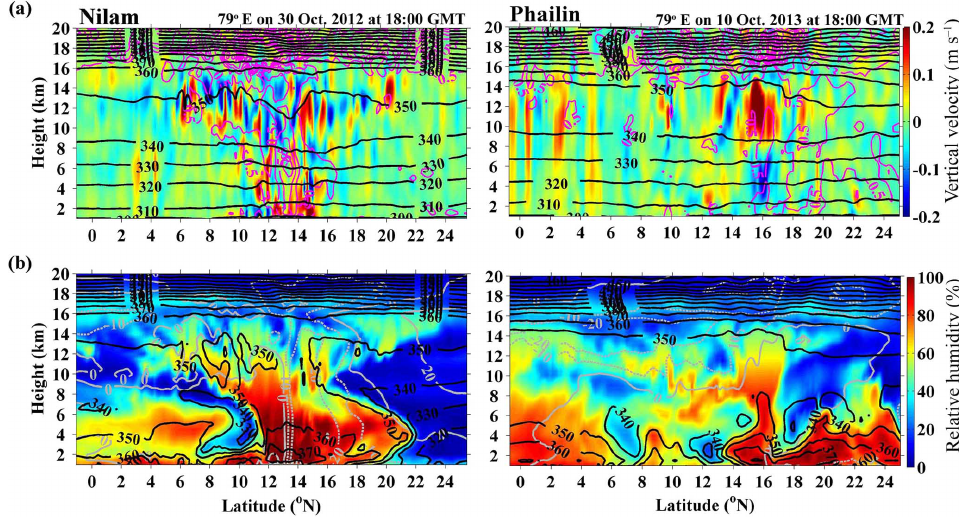
Figure 6. Same as Fig. 5 but at 79 ◦ E at 18:00GMT on 30 October 2012 for Nilam (left panels) and 18:00GMT on 10 October 2013 for Phailin (right